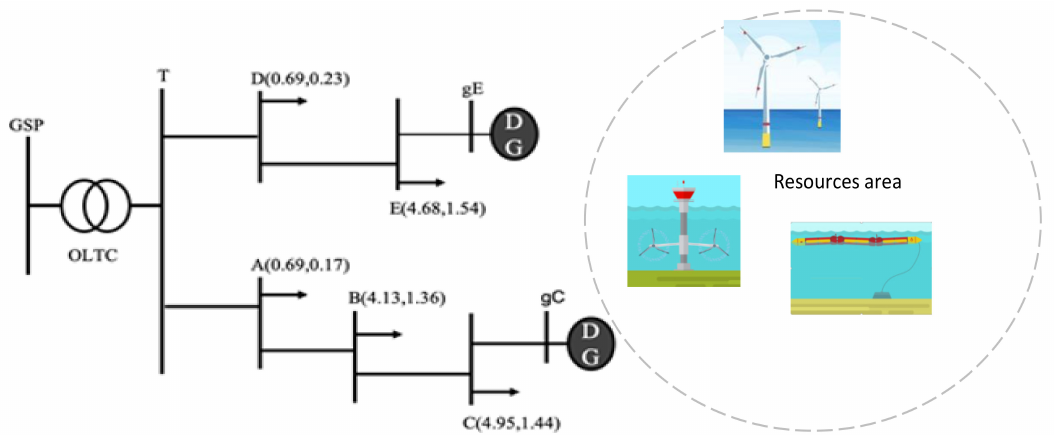
Figure 4. Rural distribution network and local resource area during maximum loading. The maximum real and reactive powers are included with the bus label, i.e., bus A: A (P,